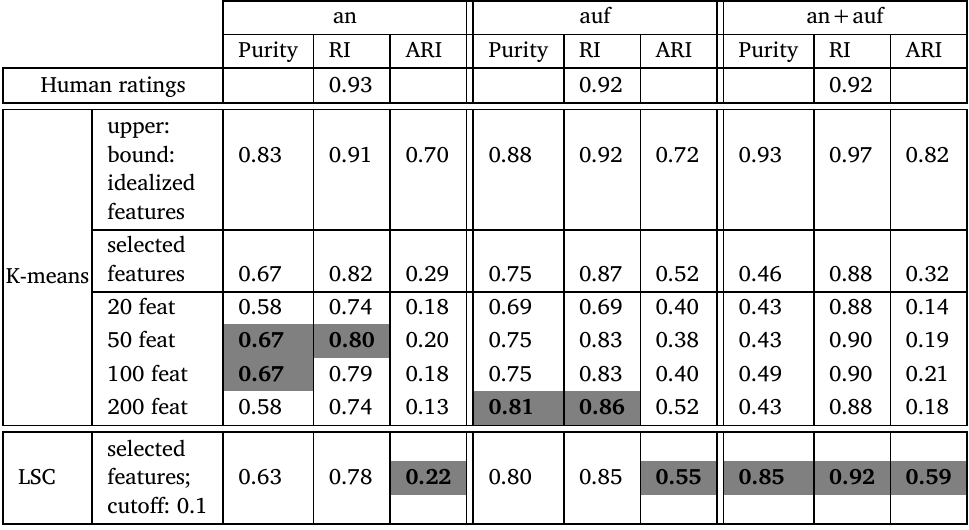
Table 3: Results across clustering methods and feature sets an auf an+auf Purity RI ARI Purity RI ARI